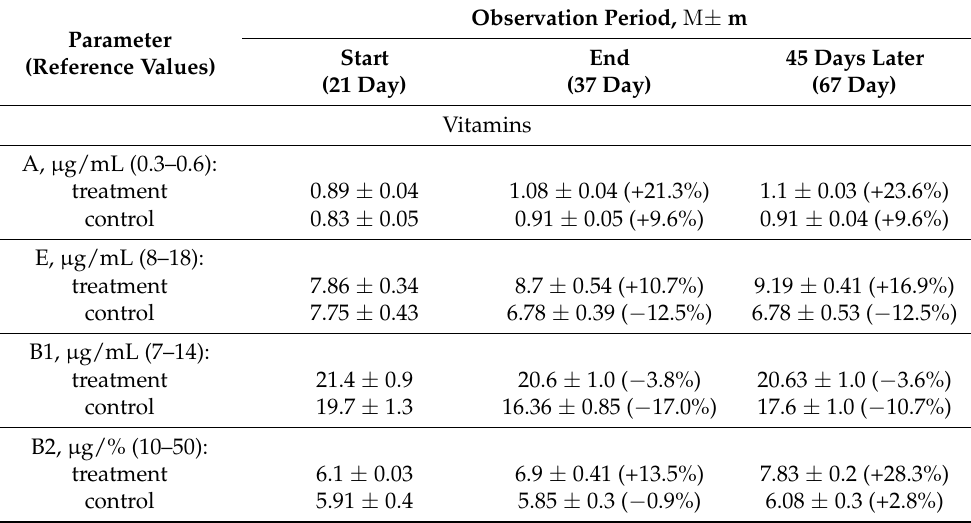
Table 3. Vitamin concentrations during the observation (absolute